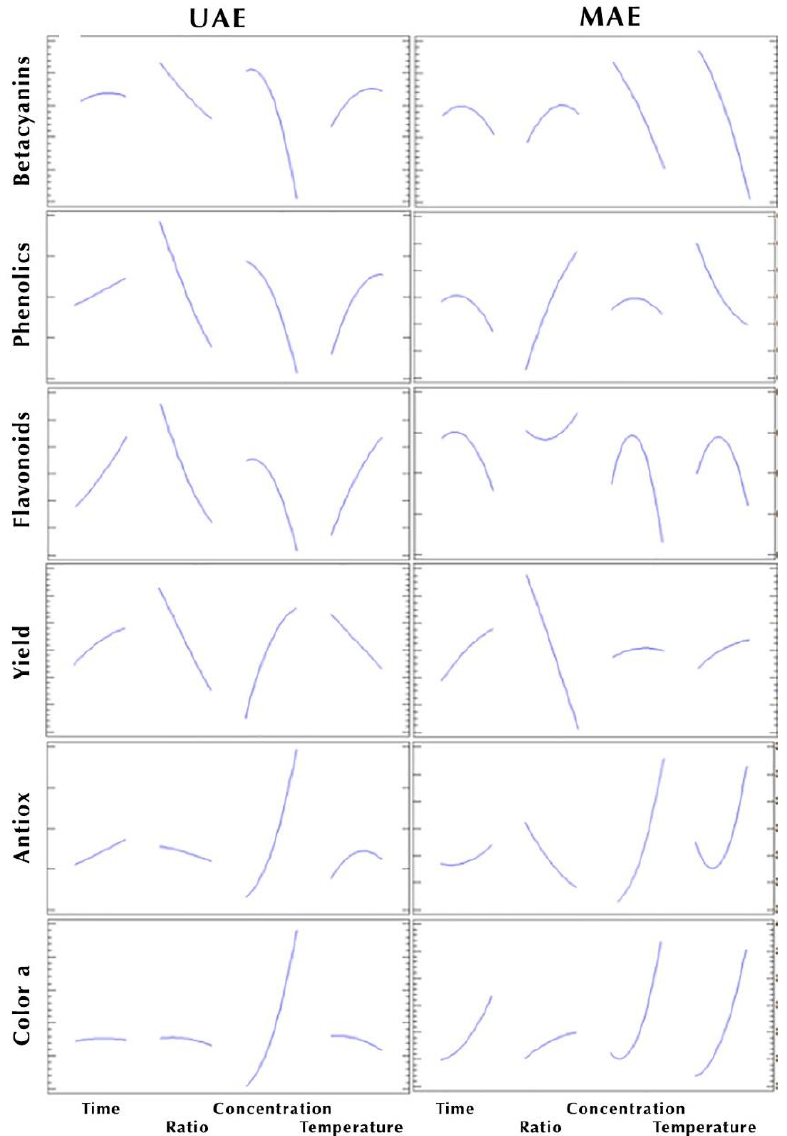
Figure 2. Principal effect graphs obtained for the ultrasound-assisted extraction (UAE) (left column) and microwave-assisted extraction (MAE) (right column), representing responses values, acquire from the independent variables employed on the CCD-RMS (central composite design-response surface methodology).